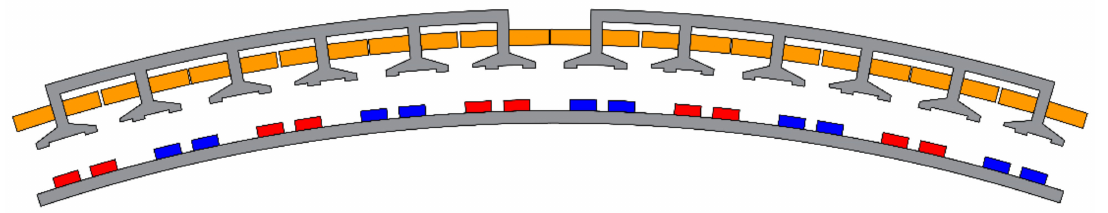
Figure 5. Single module of the APMM designed with: N i = 2, N sub = 5, x = [ 1 0 0 1 0 1 0 0 0 1 0.6 ]